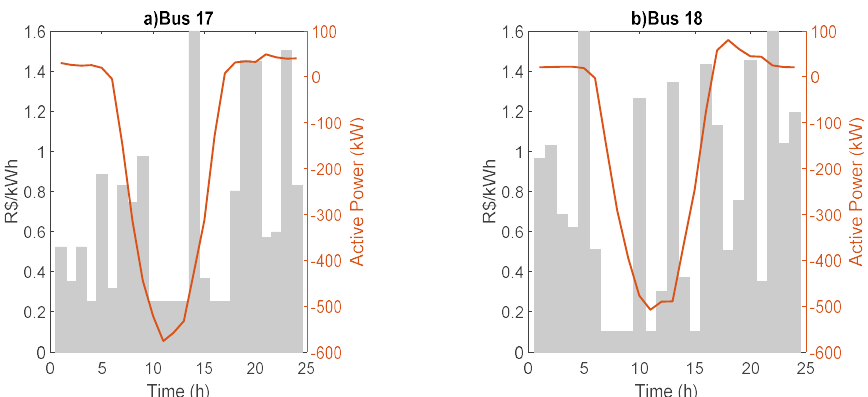
Figure 9. The impact of DR programs on total load profile with PV generation.